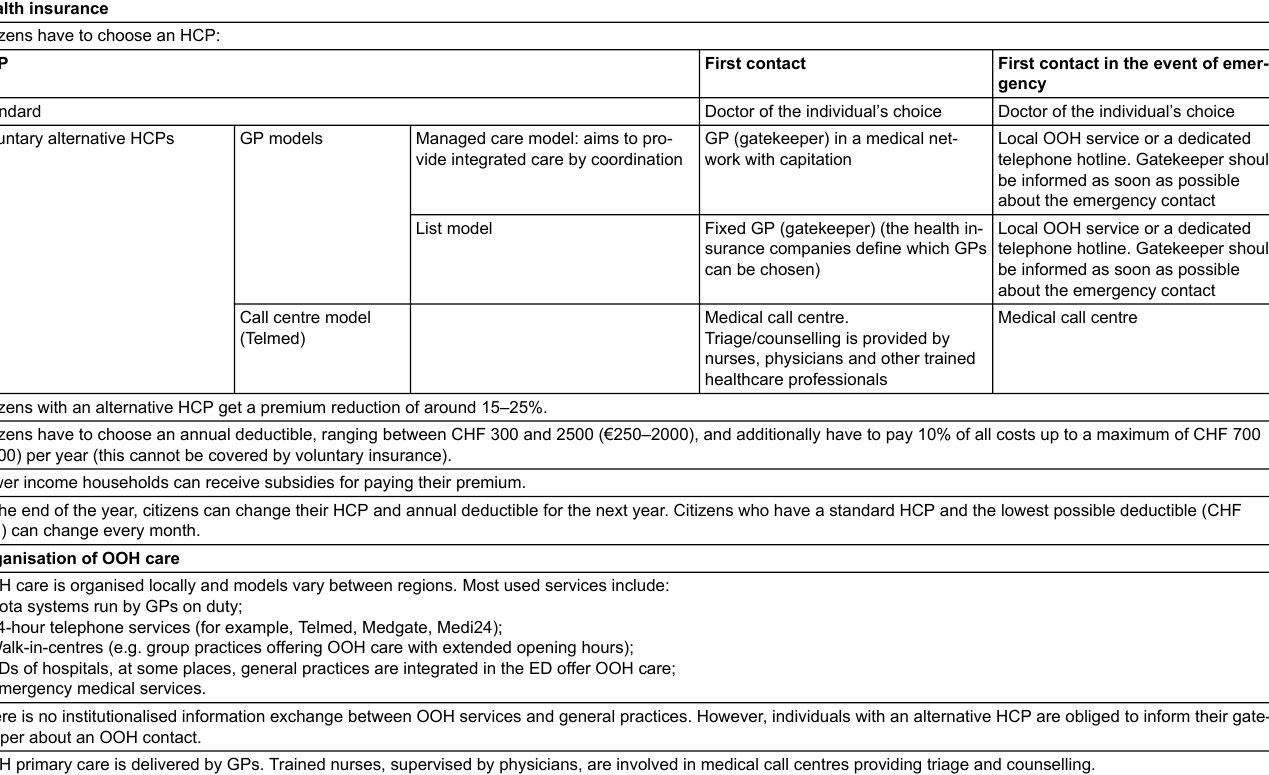
Table 1: Features of the Swiss healthcare system [18–20] Health